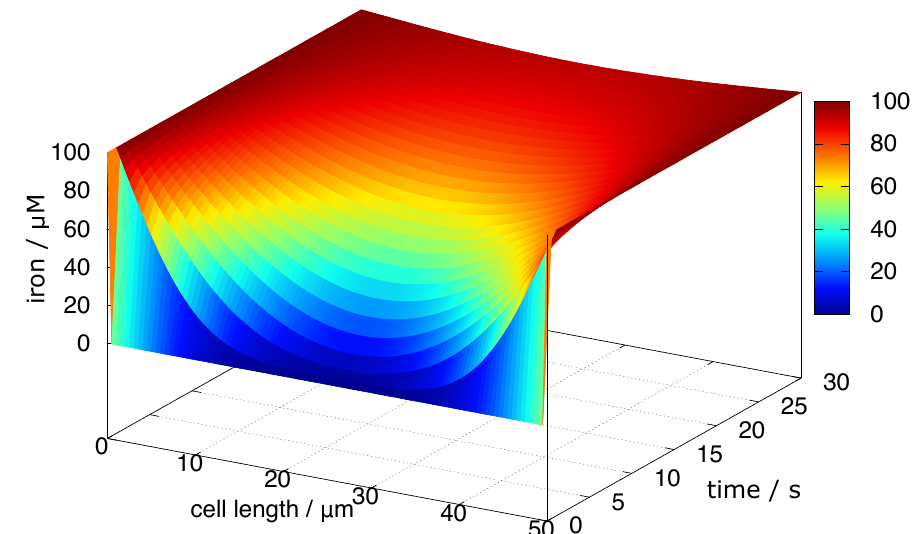
Figure 6. Diffusion of iron coordination compounds in the cell. The iron enters from both sides of the cell and diffuses in the cytosol. Cell size: 50 µ m, D = 100 µ m 2